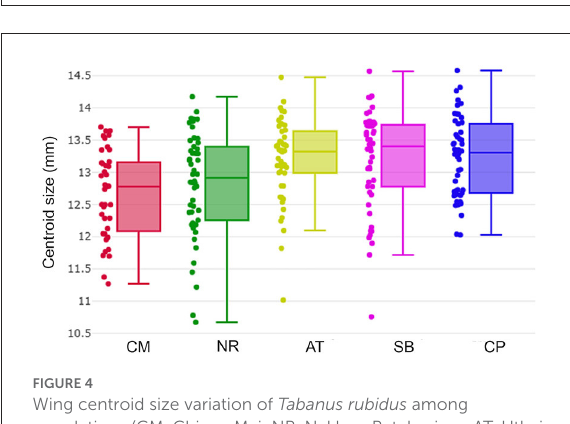
FIGURE4 Wing centroid size variation of Tabanus rubidus among populations (CM, Chiang Mai; NR, Nakhon Ratchasima; AT, Uthai Thani; SB, Singburi; CP, Chumphon). Each box plot displays the median with the 25 th and 75 th quartiles. Dots along the sides of each box represent the individual